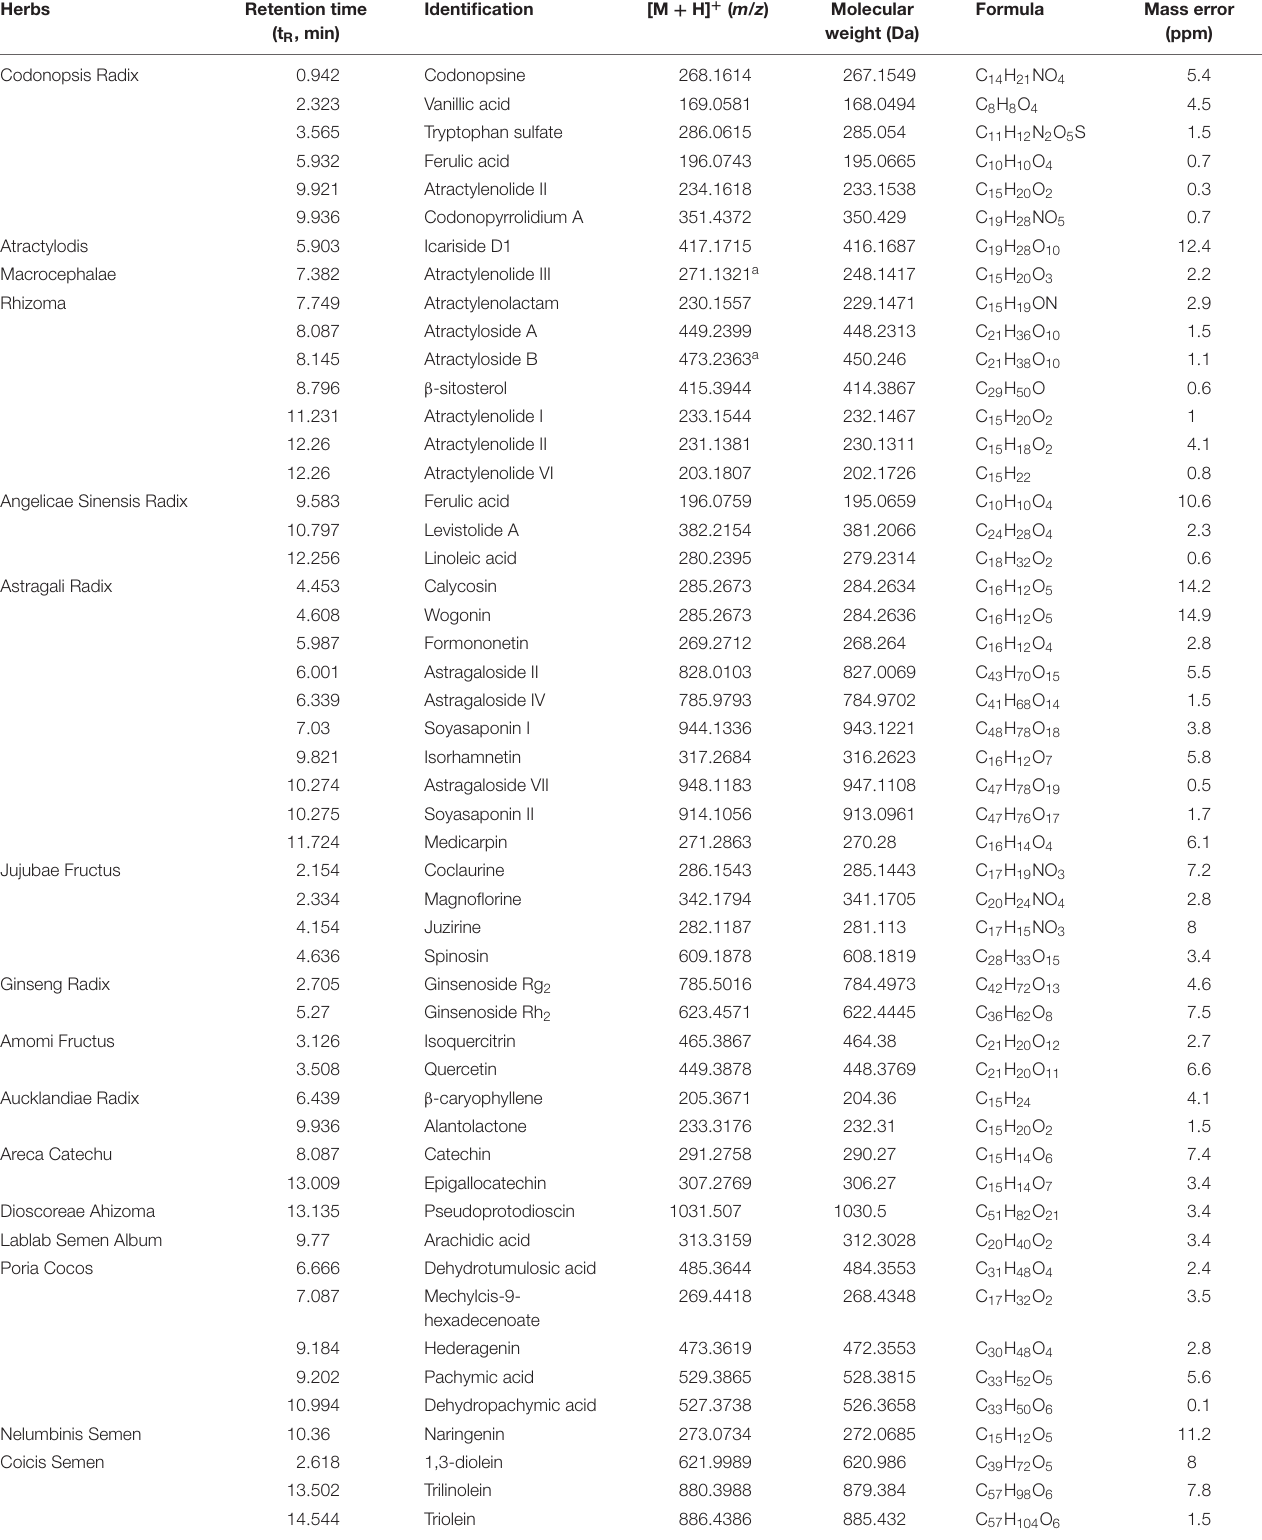
TABLE 2 | The compounds identified from the herbal extracts.